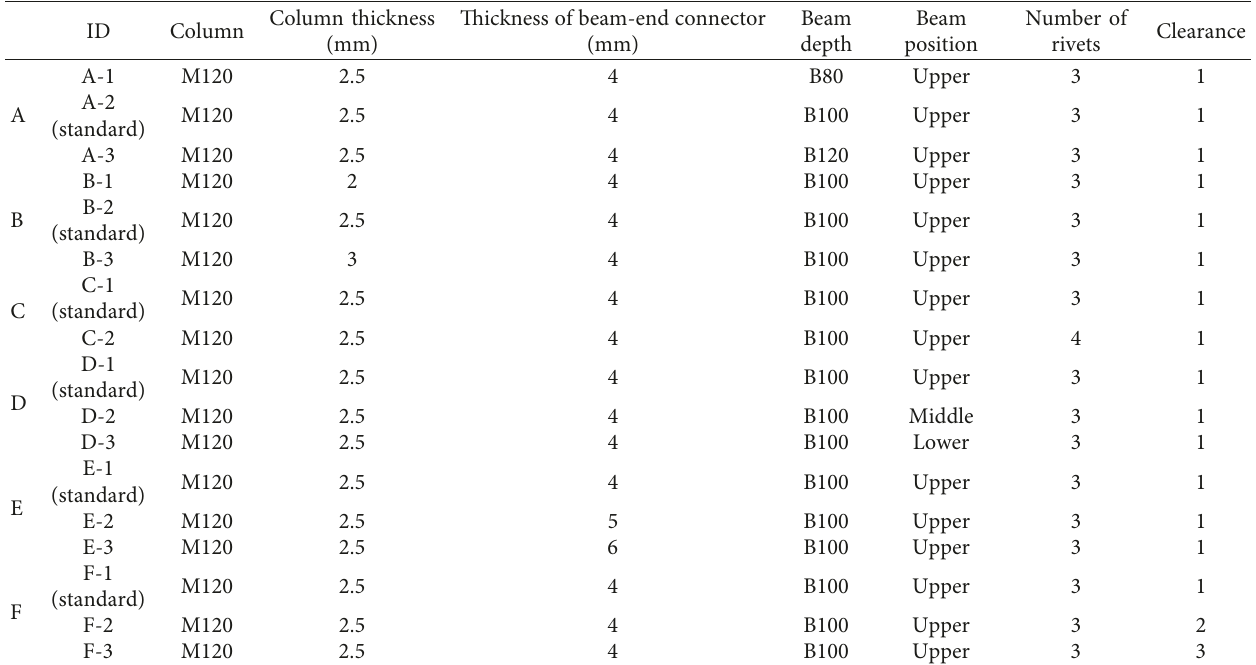
Table 3: Details of